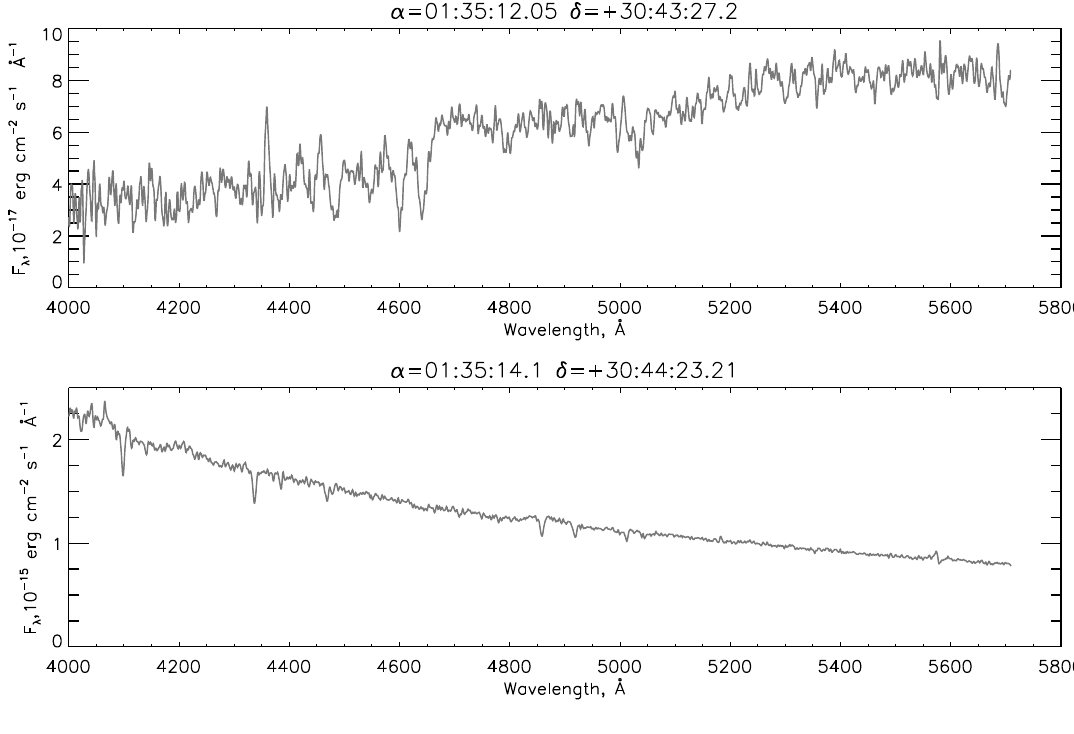
Figure A5. From the top panel downwards, spectra of the stars: J013512.05+304327.2 and